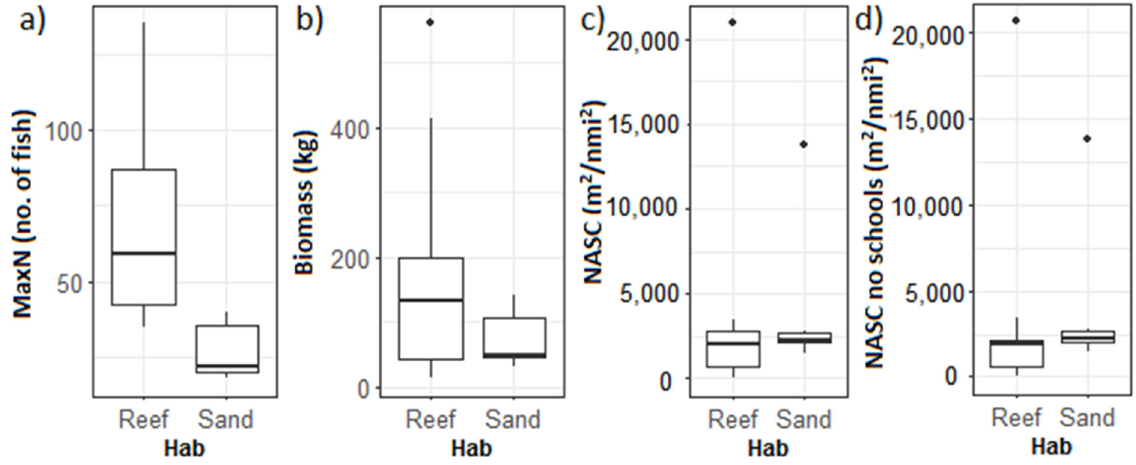
Figure 10. Box plots of the ( a ) relative abundance from the stereo-BRUVs (MaxN), ( b ) relative biomass (kg) from the stereo-BRUVs, ( c ) acoustic NASC BRUV-mean , and ( d ) acoustic NASC BRUV-mean no schools, grouped by benthic habitat observed in the videos.